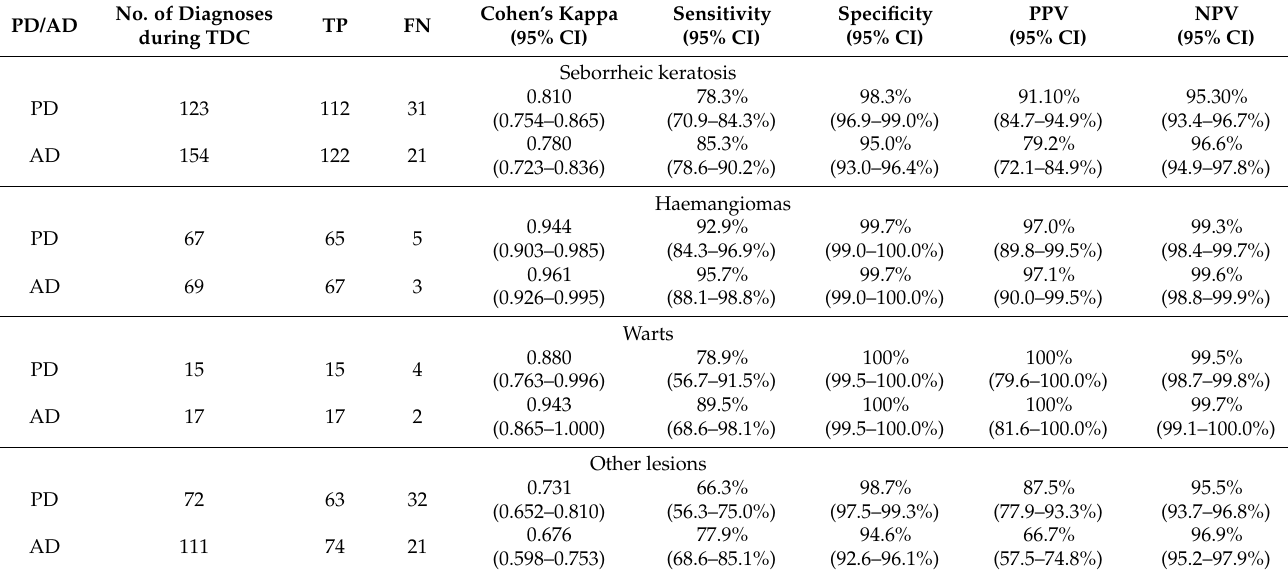
Table 6. Diagnostic agreement of SK, haemangiomas, warts and other lesions